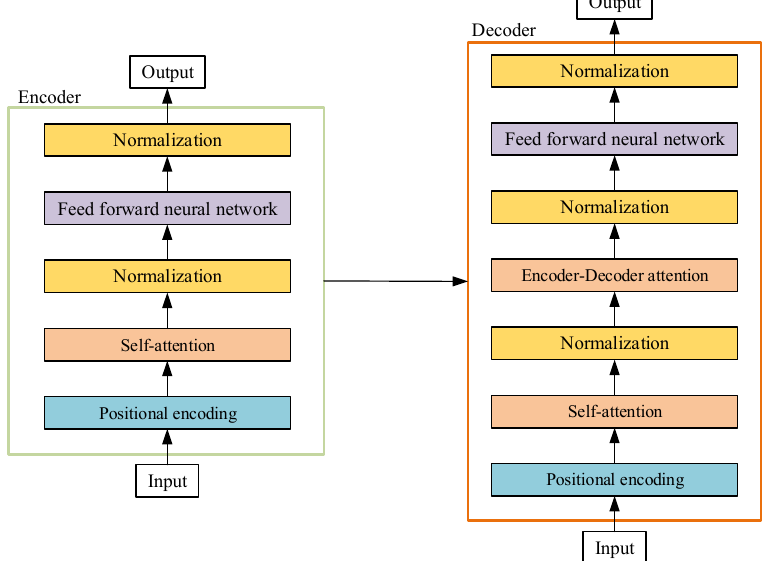
Figure 2. Internal Structure of Encoder and Decoder.